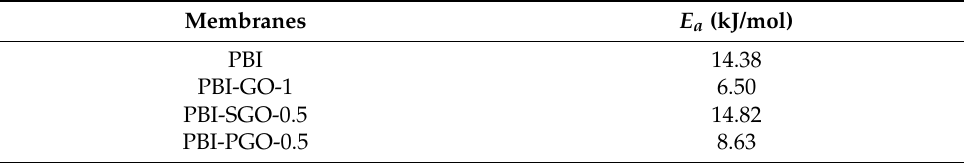
Figure 10. Arrhenius plot of selected PBI membranes. Table 1. The activation energy of the selected PBI membranes.